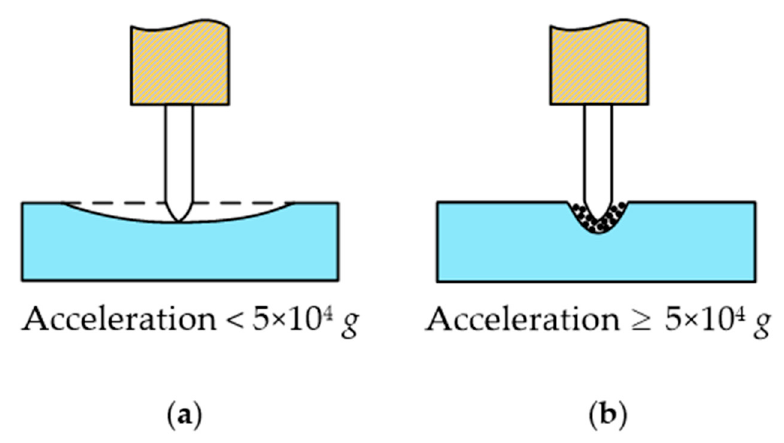
Figure 6. Different cases of the ultrasonic cutting of biological tissue. ( a ) If mechanical vibration with a particle acceleration of less than 5 × 10 4 g is applied to living biological tissue then tissue cannot be cut, and the biological tissue would act in a similar manner to an elastic body with two fixed ends and the middle pressed down. ( b ) If mechanical vibration with a particle acceleration of equal to or more than 5 × 10 4 g is applied to living biological tissue then tissue can be quickly cut and will not hurt the surrounding tissue.